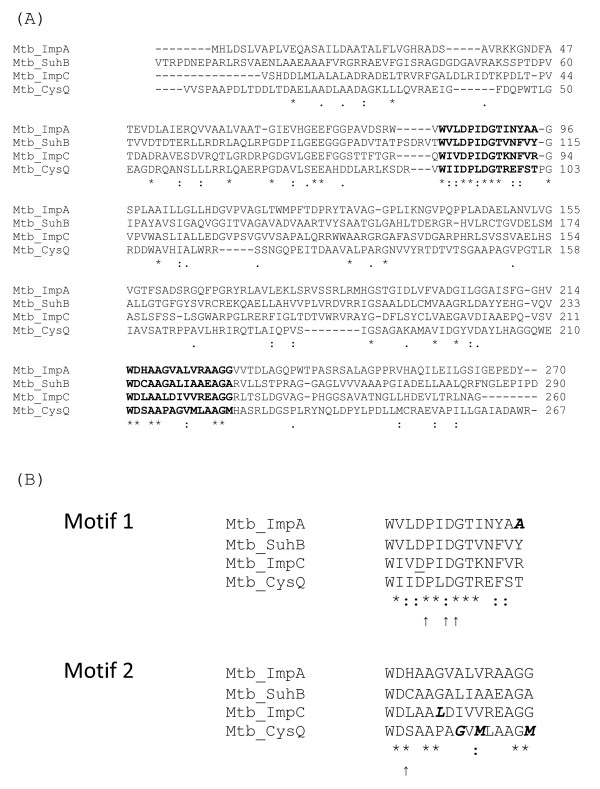
Alignment of IMPases. The M. tuberculosis H37RvIMPases were aligned using ClustalW. (A) Complete sequences. Motifs shown in bold; (B) Prosite motifs: '*' identical residues in all sequences; ':' conserved substitutions; '.' semi-conserved substitutions. Sequences were obtained from http://genolist.pasteur.fr/TubercuList/. Reported Prosite motifs are 1 (N-terminal; PS00629): [FWV]-x(0,1)- [LIVM]-D-P- [LIVM]-D- [SG]- [ST]-x(2)- [FY]-x- [HKRNSTY]; and 2 (C-terminal; PS00630): [WYV]-D-x- [AC]- [GSA]- [GSAPV]-x- [LIVFACP]- [LIVM]- [LIVAC]-x(3)- [GH]- [GA]. Residues that are not encompassed by these motifs are in bold italics. Arrows indicate putative metal binding aspartate and isoleucine residues reported for human IMPase [55]. The underlined residue shows the aspartate mutated in this study, which is equivalent to mutations introduced into the E. coli and human proteins (see main text).